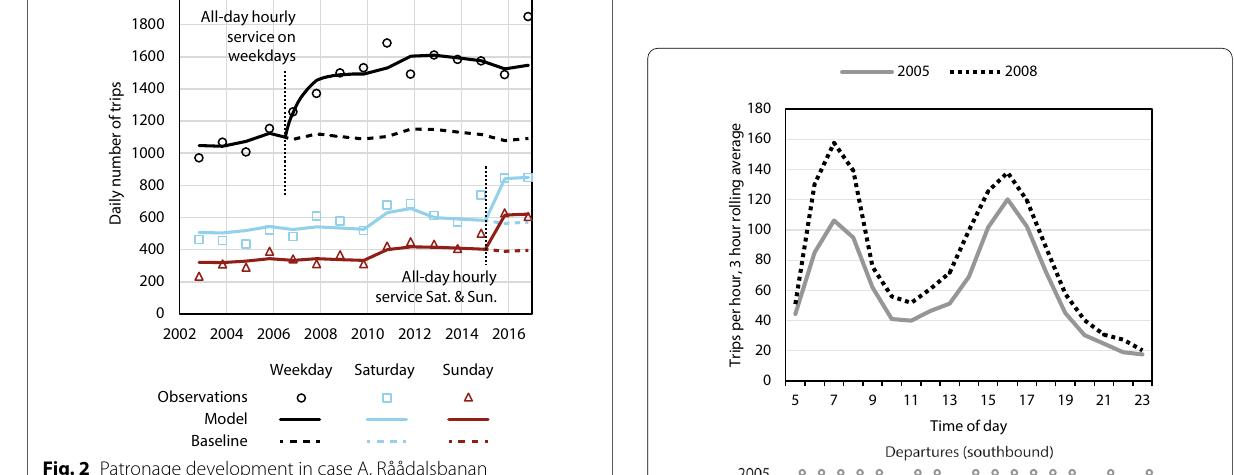
Fig. 2 Patronage development in case A, Råådalsbanan (excluding the new stations opened in 2001), showing annual autumn measurements and model estimations of the patronage development with and without off‑peak service improvements (the latter corresponds to the counterfactual baseline scenario)